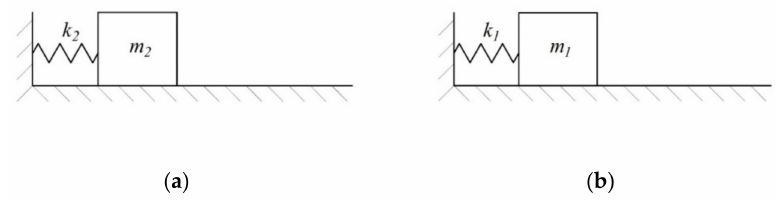
Figure 8. ( a ) The equivalent model of point A; ( b ) the equivalent model of point C.